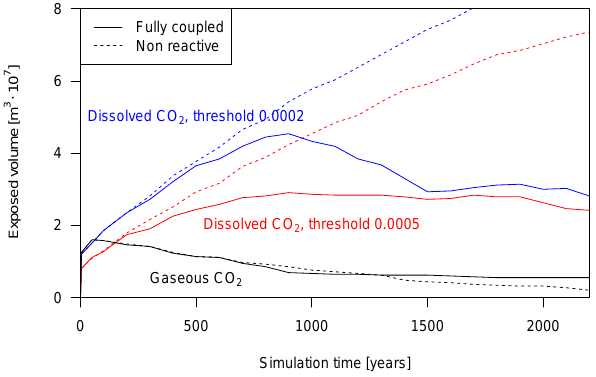
Figure 4. Homogeneous simulations: reservoir volume exposed to CO 2 distinguishing between elements exposed to gaseous phase (black lines) and to dissolved CO 2 only (red; blue following the threshold for the minimum considered concentration in terms of mass fraction).